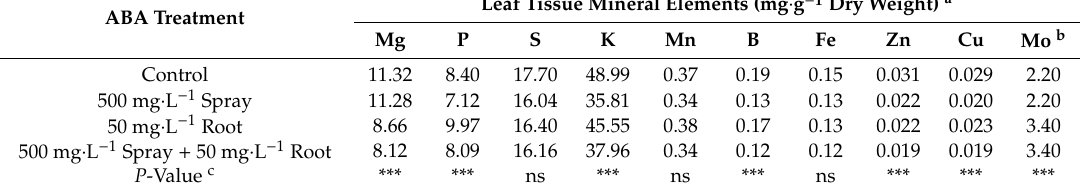
Table 1. Mineral nutrients in leaf tissue of ‘Mt. Fresh Plus’ tomato plants grown in a greenhouse and treated with DI water, as control, or exogenous applications of abscisic acid (ABA); either foliar